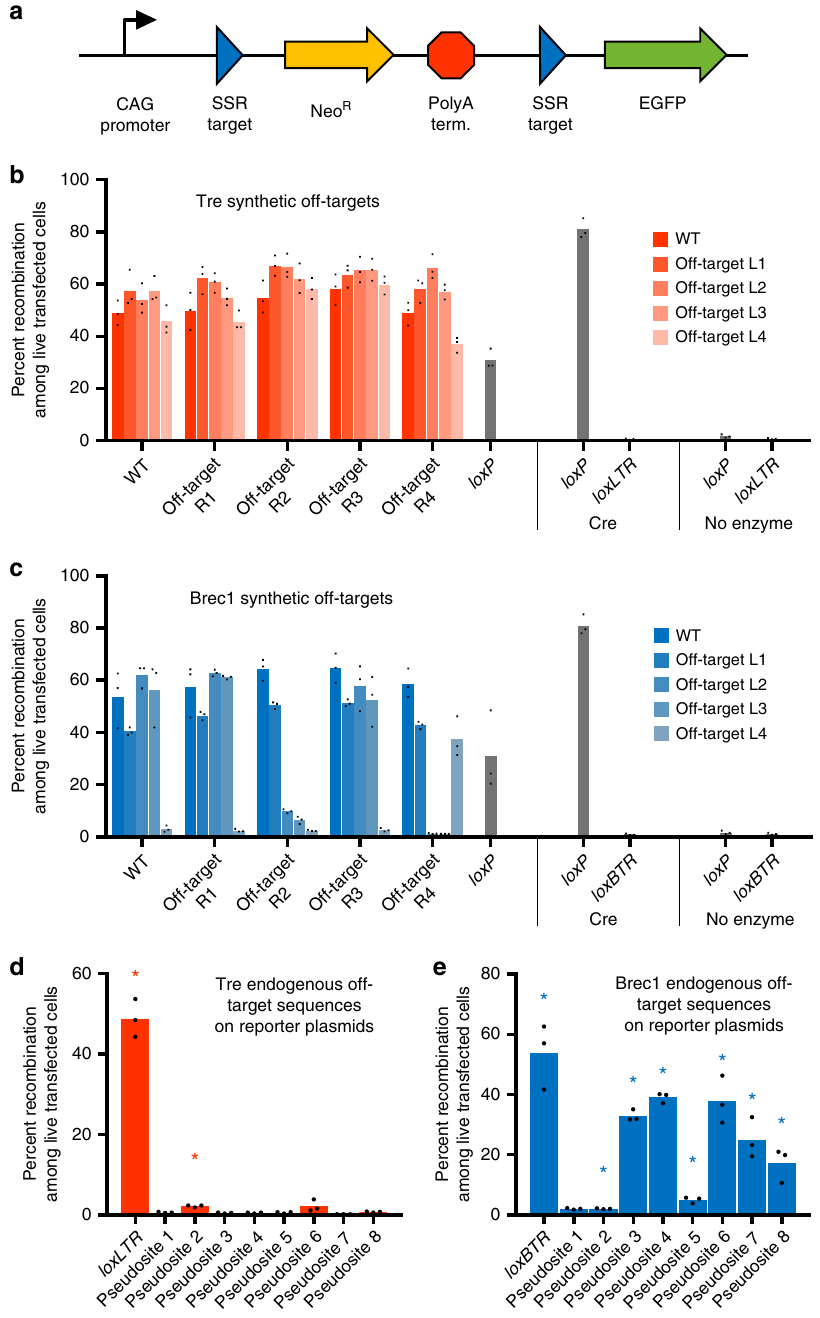
Fig. 5 Off-target recombinase activity predicted by Rec-seq. a Cells were transfected with recombinase expression plasmid and an EGFP reporter plasmid containing candidate recombinase substrates fl anking a poly-A terminator that blocks EGFP transcription. Tre and Brec1 activity on synthetic off-target substrates ( b , c ) and predicted endogenous human genomic pseudosites ( d , e ) was measured as the fraction of cells exhibiting EGFP fl uorescence. The percentage of EGFP-positive cells shown is of transfected cells (determined by gating for the presence of co-transfected plasmid constitutively expressing mCherry) and 10,000 live events were recorded for each experiment. Data are represented as the mean (bars) of three independent biological replicates (dots). For d , e , signi fi cant differences ( p ≤ 0.05) relative to no-enzyme control samples are indicated (Student's two-tailed t-test; colored asterisks). Source data are provided as a Source Data fi le